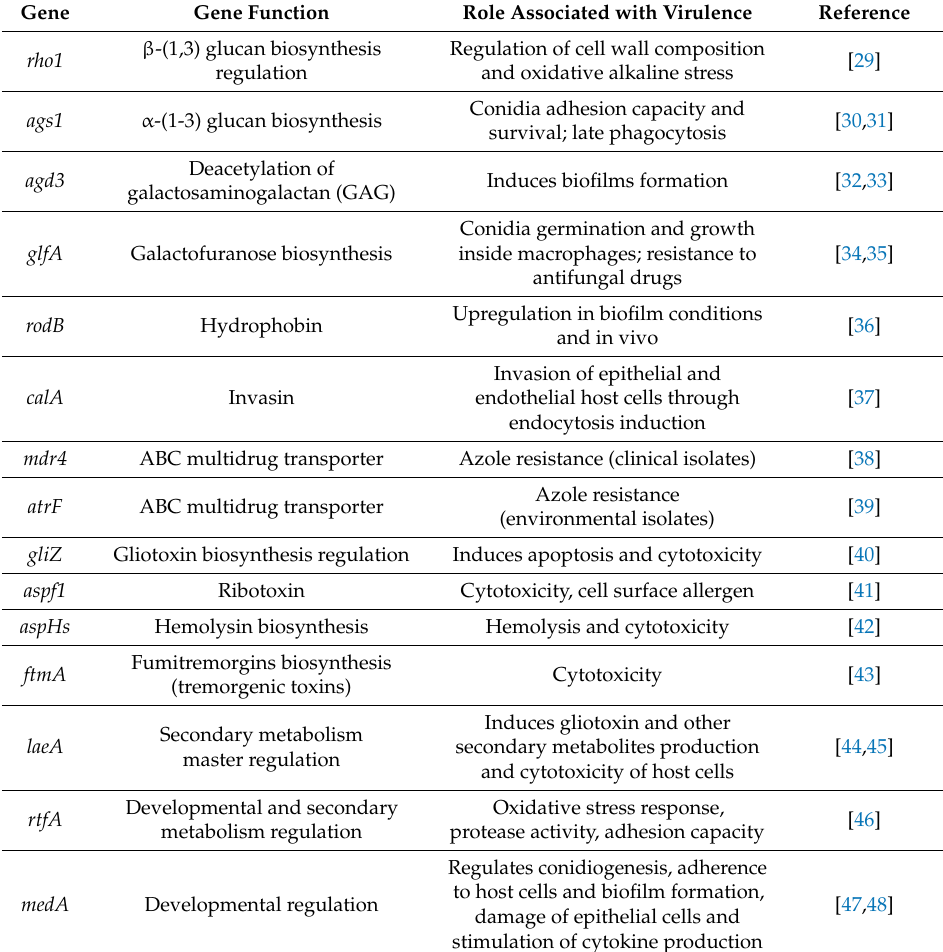
Table 1. Selected virulence-related genes found in the genome of the saprophytic strain LMB-35Aa, considering the clinical strain A. fumigatus Af293 as a